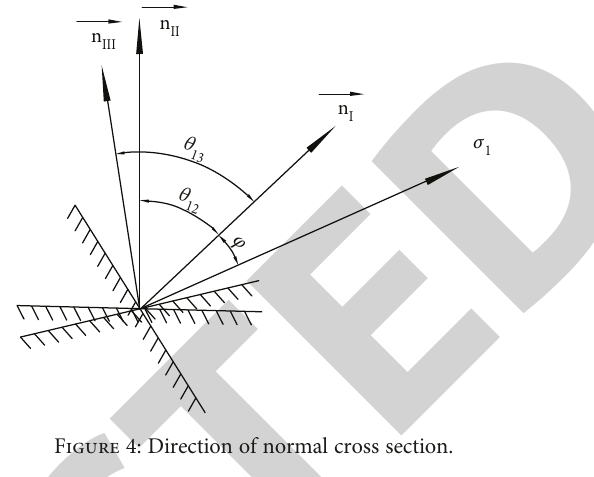
Figure 4: Direction of normal cross